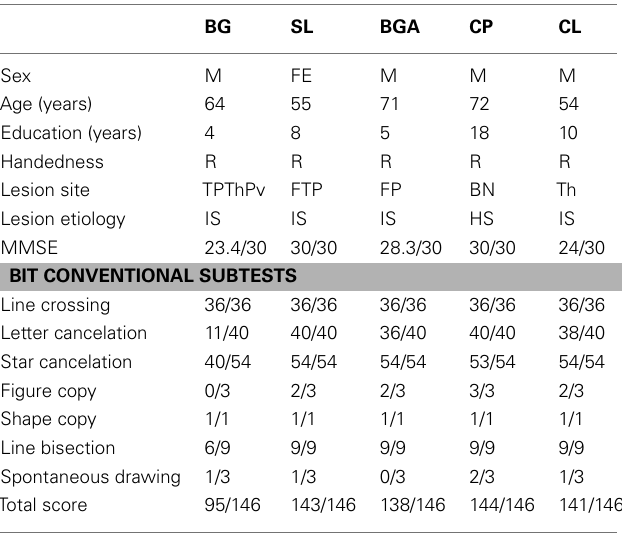
Table 1 | Demographic, clinical, and psychometric data of the